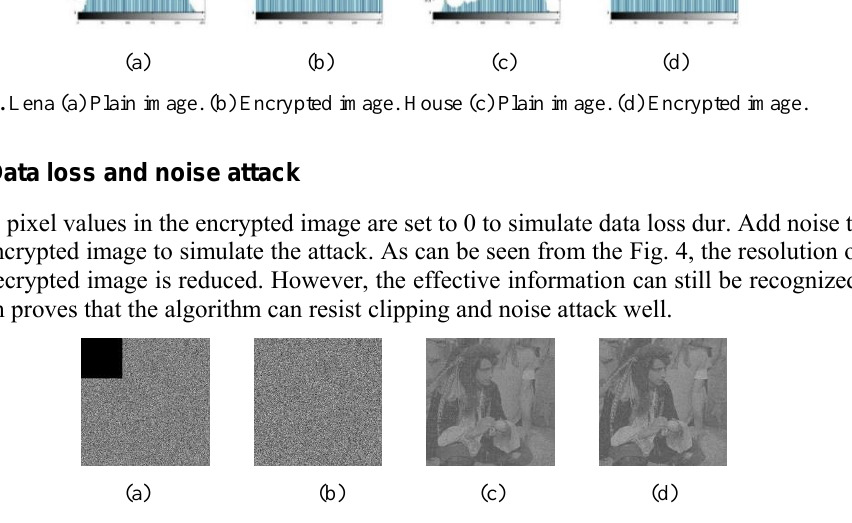
Fig. 4. (a) The encrypted image with 10% data loss. (b) The encrypted image added with 10% noise. (b) The decrypted image of (a). (e) The decrypted image of